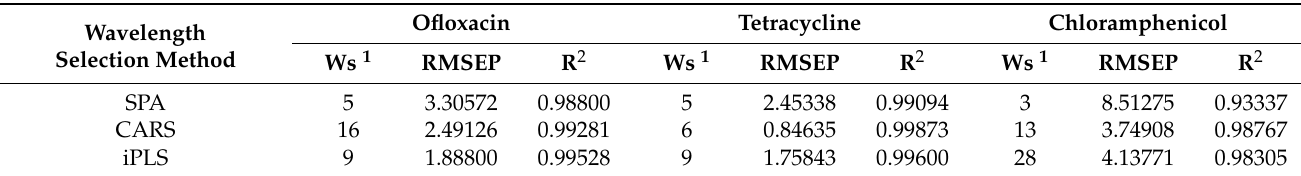
Table 6. Ws, RMSEP, and R 2 using different wavelength selection